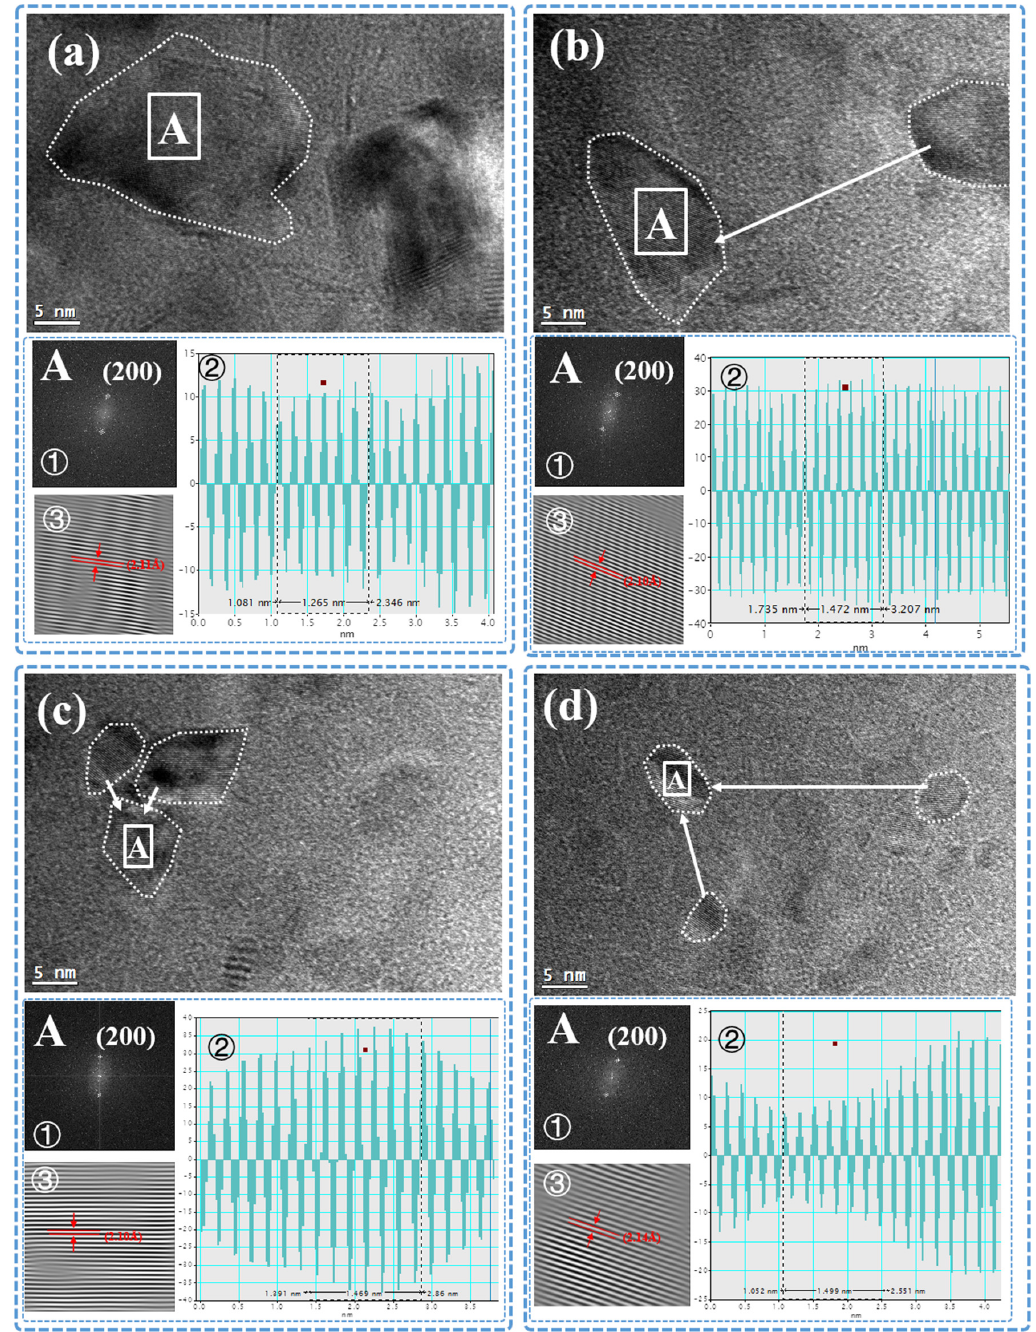
Figure 9. TEM high-resolution (HRTEM) images of different composite films: ( a ) 1:1 Al 2 O 3 :MgO layer alternation type, ( b ) 2:1 Al 2 O 3 :MgO layer alternation type, ( c ) 3:2 Al 2 O 3 :MgO layer alternation type, and ( d ) 5:4 Al 2 O 3 :MgO layer alternation